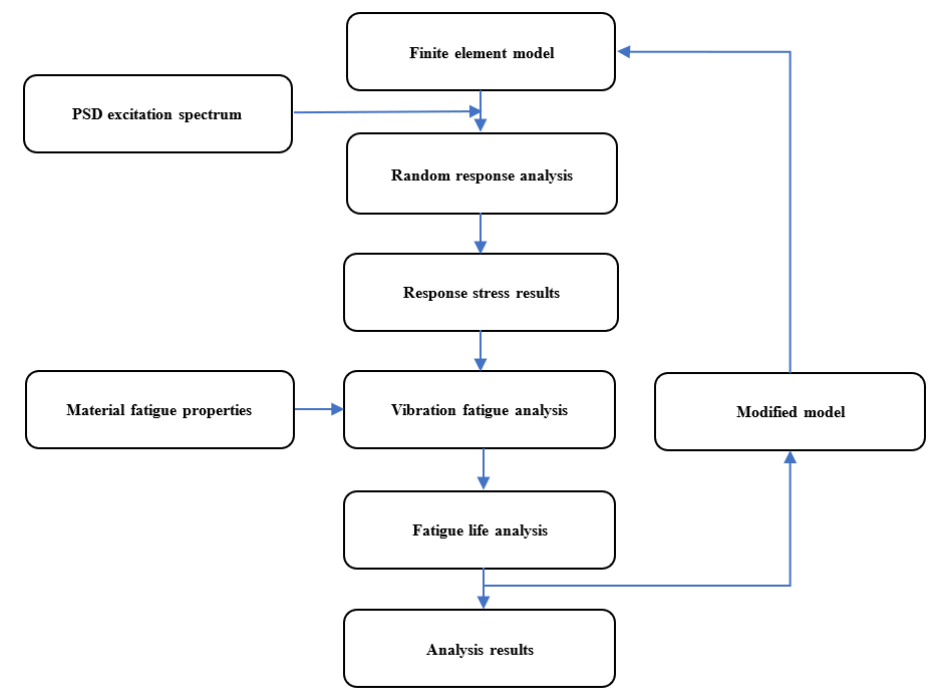
Figure 3. Finite element fatigue life analysis process.